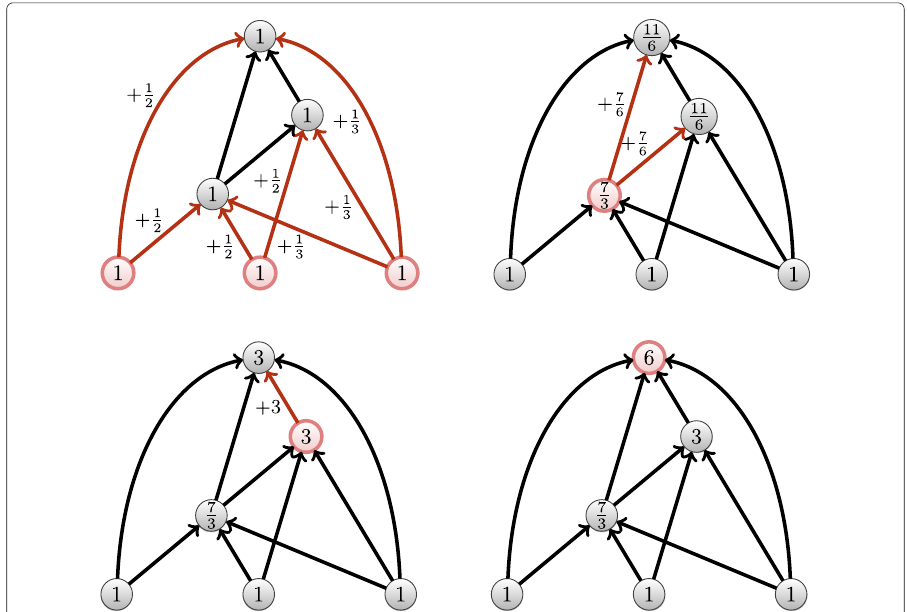
Fig. 1 Ascending flow algorithm: step by